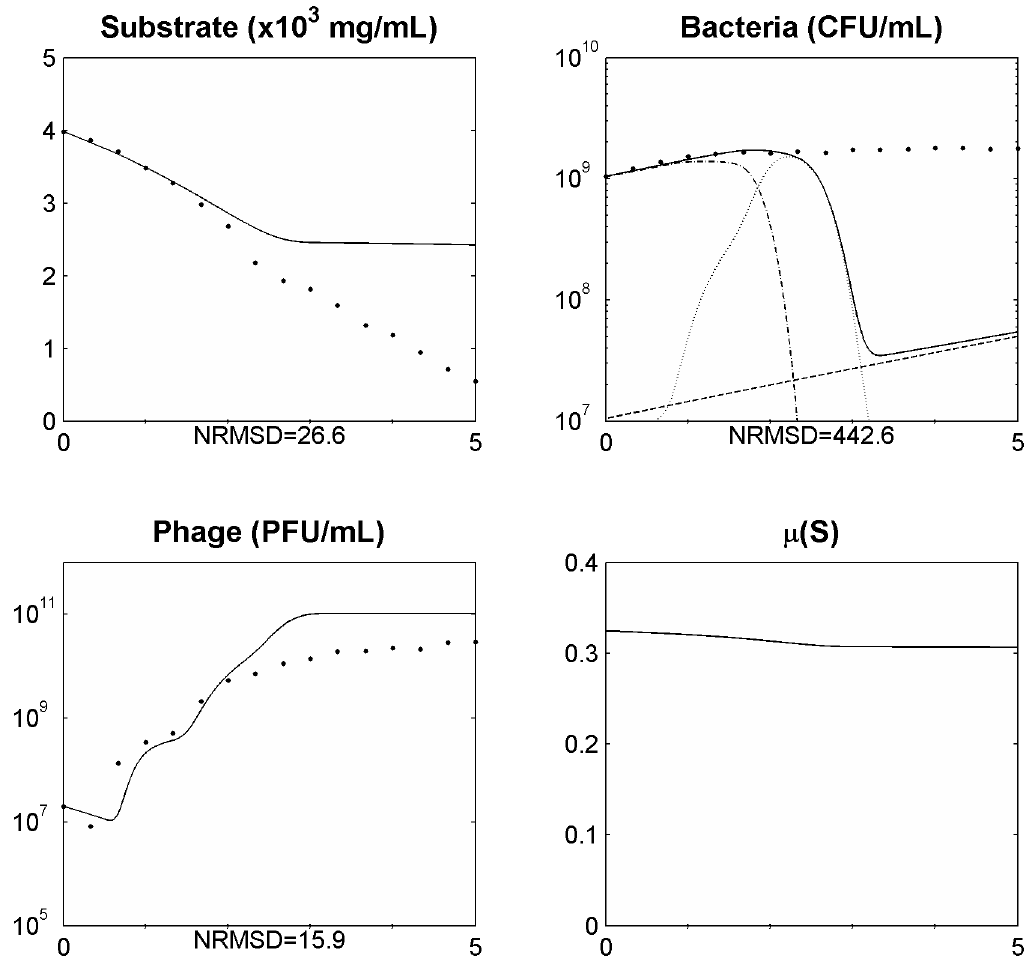
Figure 2. Simulating the phage and bacteria population dynamics using a distribution of values of the latent period (equations 6– 14) in a 250 ml Erlenmeyer flask for a MOI=1.8E10 2 2 . Legend: N experimental data; ___ model simulation; - . - model simulation of susceptible uninfected bacteria ( X s ); … model simulation of infected bacteria ( X i ); _ _ model simulation of resistant bacteria ( X r ). The x axis represents time in hours.